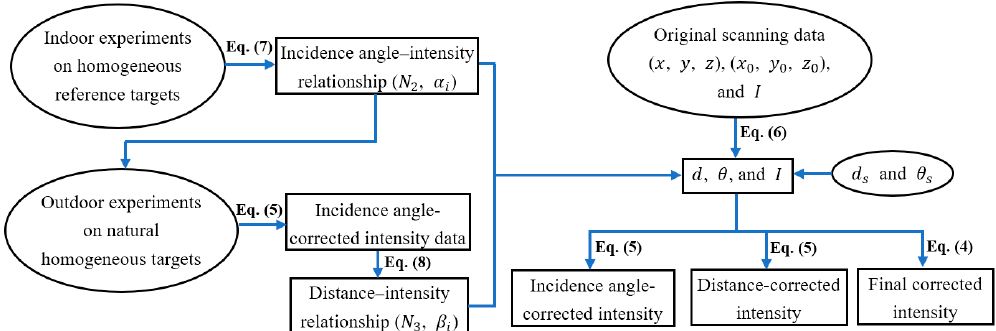
Figure 1. Flowchart of the improved method.